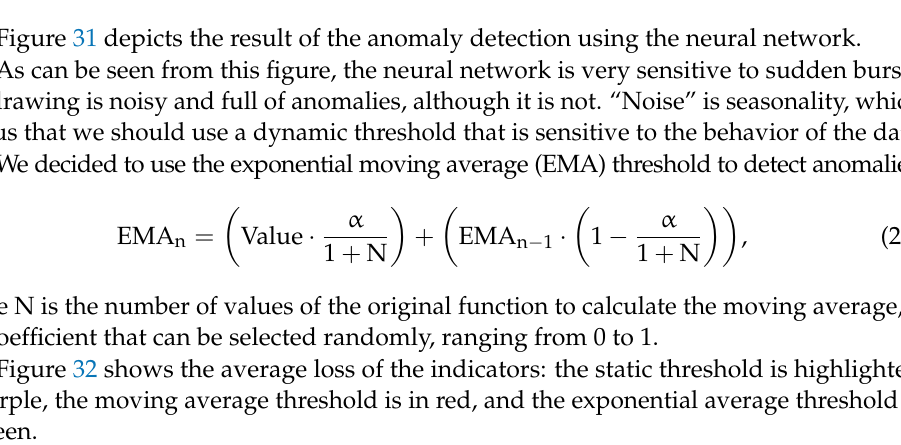
Figure 30. Calculation of static threshold